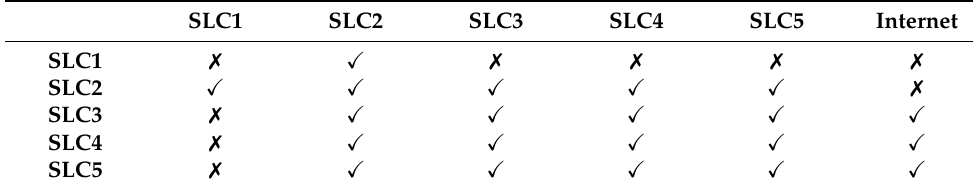
Table 12. The suggested communication plan.